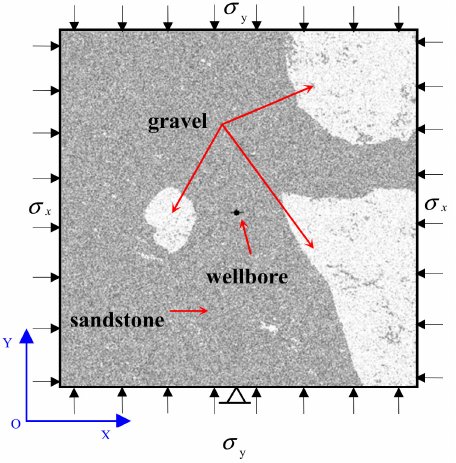
Figure 10. The 2D numerical model.